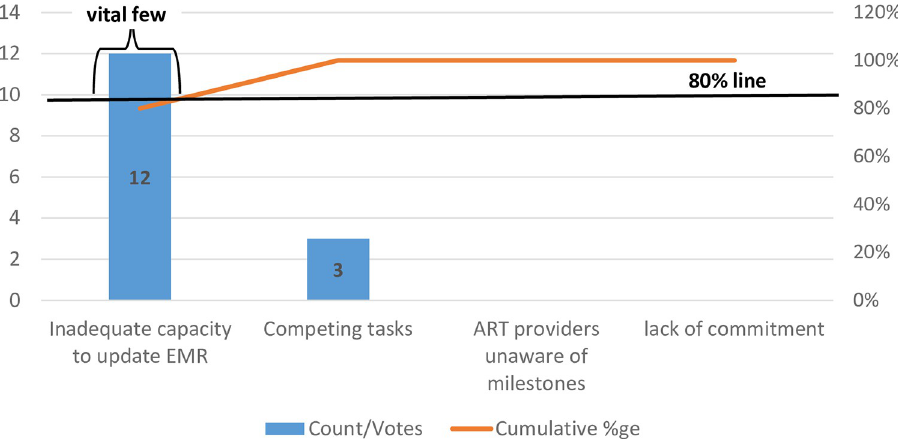
Fig 2. Pareto chart of prioritizing factors affecting low VL coverage at Chilomoni health centre, Blantyre.